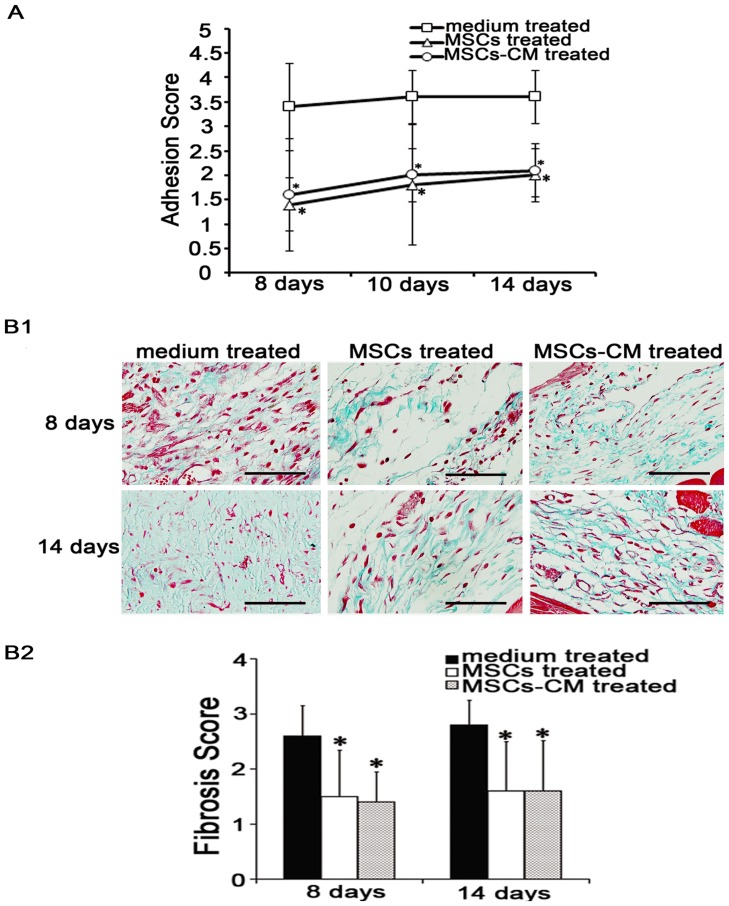
Effects of mesenchymal stem cells (MSCs)-conditioned medium (CM) on acute peritoneal adhesions.(A). The MSCs-CM treated group had lower adhesion scores days 14 after scraping. The size and severity of peritoneal adhesions were evaluated macroscopically by an independent observer on a scale of 0–4 (0, 0%; 1, <25%; 2, 25–49%; 3, 50–74%; and 4, 75–100% adhesions).* compared with medium treated group, p <0.05, n  = 6, respectively. (B). Masson's trichrome staining revealed that the changes of fibrosis in acute peritoneal adhesions. (B1). The fibrosis in the scraped peritoneum days 8, 14 after scraping was decreased by injecting MSCs-CM. Magnification  =  ×400. (B2). The scores of peritoneal fibrosis were reduced by injecting MSCs-CM, similar to MSC. * compared with medium treated group, p <0.05, n  = 6, respectively. The sections were evaluated from five randomly selected fields under a magnification of ×100 by an independent pathologist. The extent of fibrosis was scored as 0 (negative), 1 (weak), 2 (medium), or 3 (intensive).